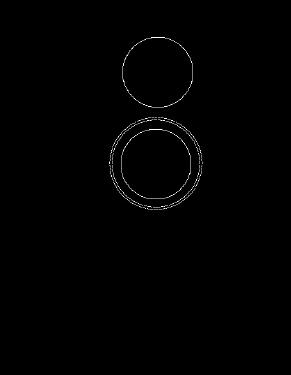
Figure 8: Arcs detected by our algorithm